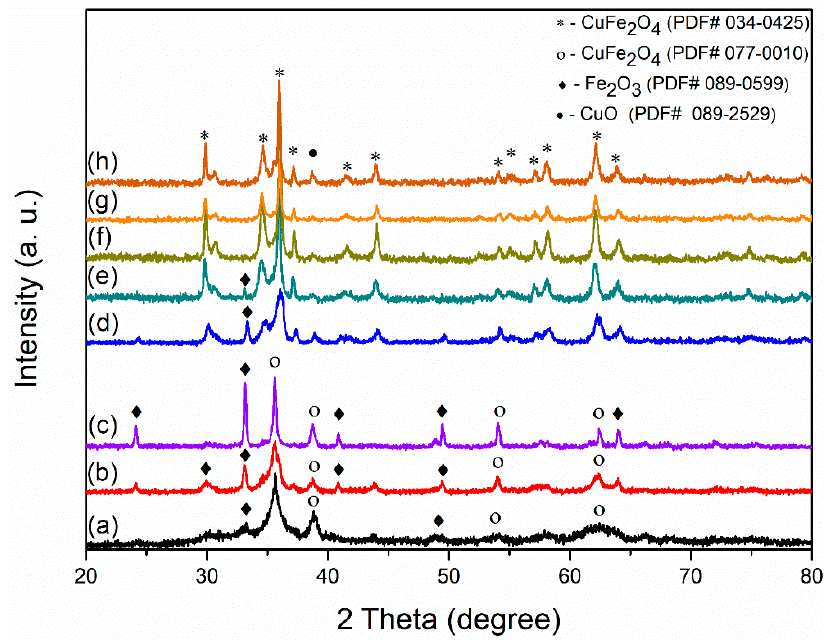
Figure 2. The CuFe 2 O 4 XRD standards: ( a ) 400, ( b ) 500, ( c ) 600, ( d ) 700, ( e ) 800, ( f ) 900, ( g ) 1000, and ( h ) 1100 °C.